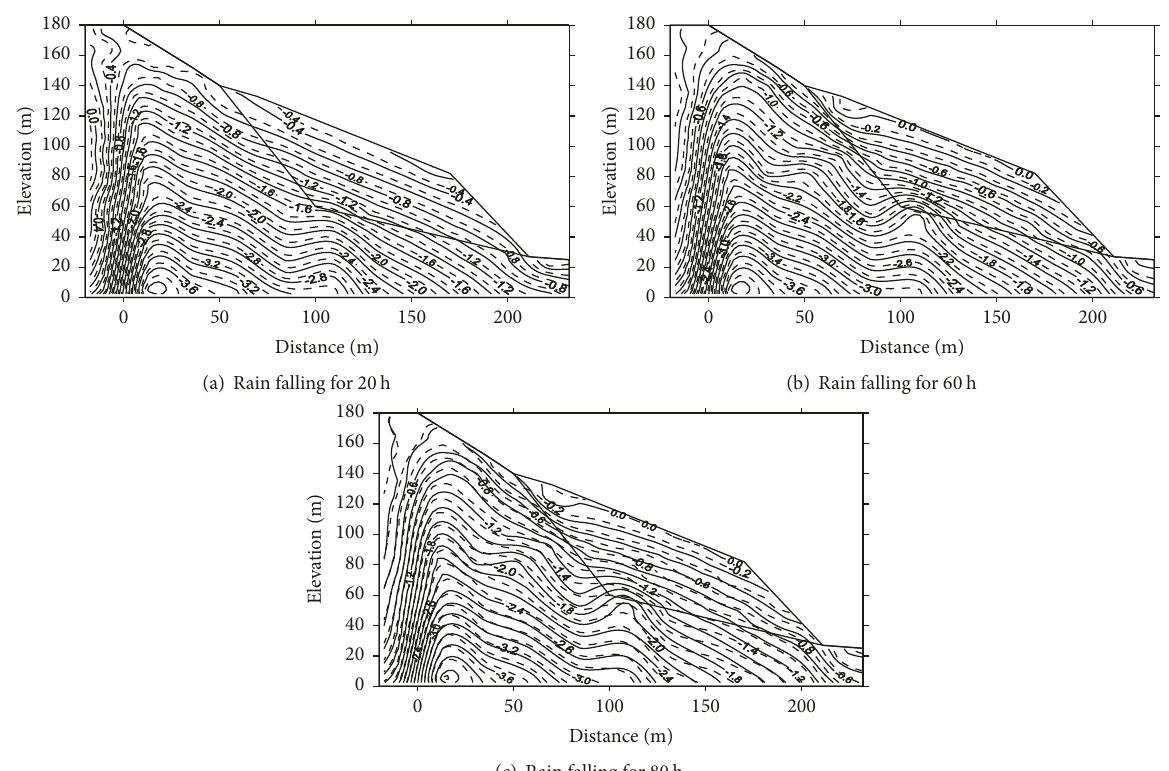
Figure 13: Maximum principle stress contours for coupling (dashed line) and uncoupling (solid line) (20